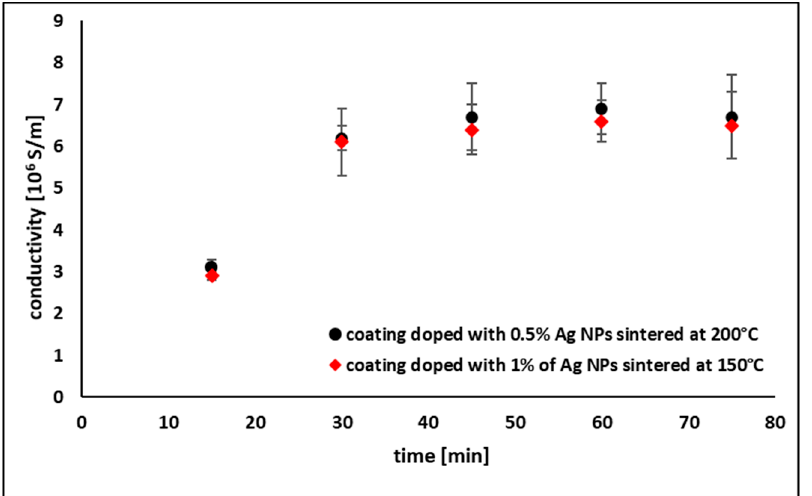
Figure 6. The dependence of the conductivity of metallic films based on Ni-Ag NPs (main filler) doped with 0.5% (circles) or 1% (rhombus) of Ag NPs on the sintering time at the sintering temperature of 200 °C and 150 °C, respectively.